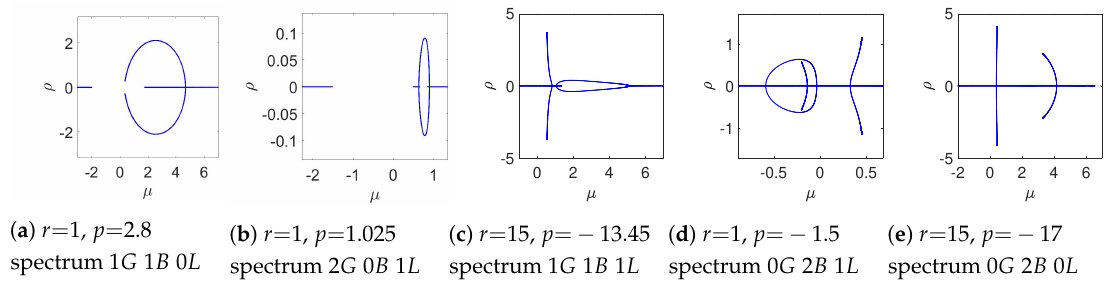
Figure 2. Examples of the five types of spectra in Equation